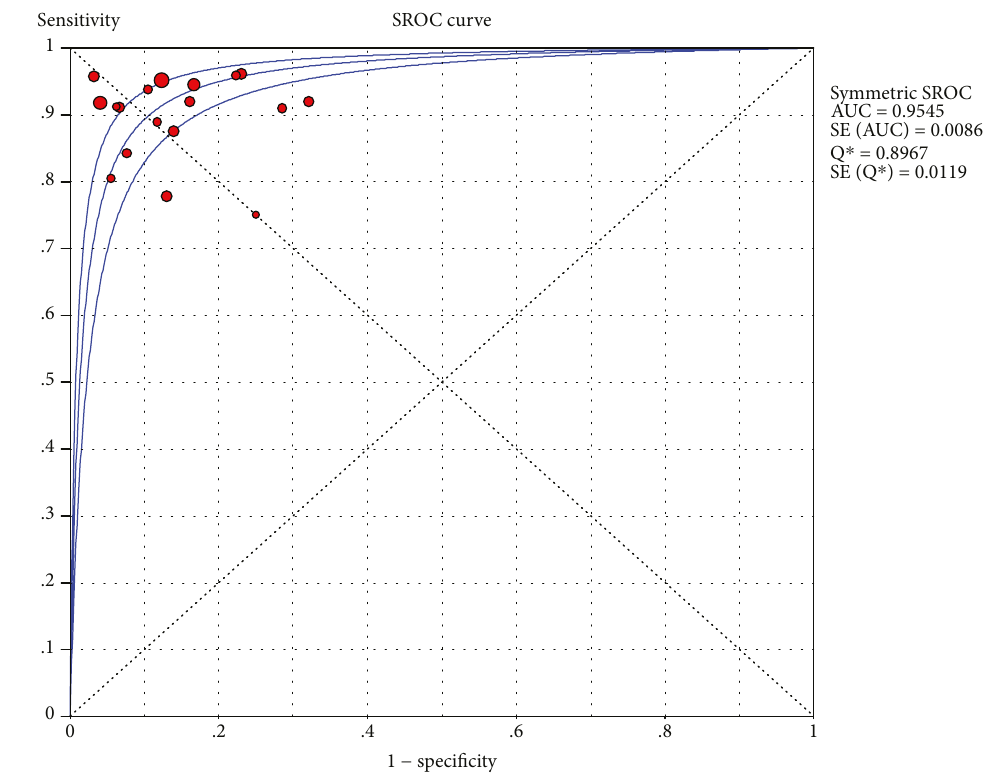
Figure 4: Symmetric SROC of the selected studies and this